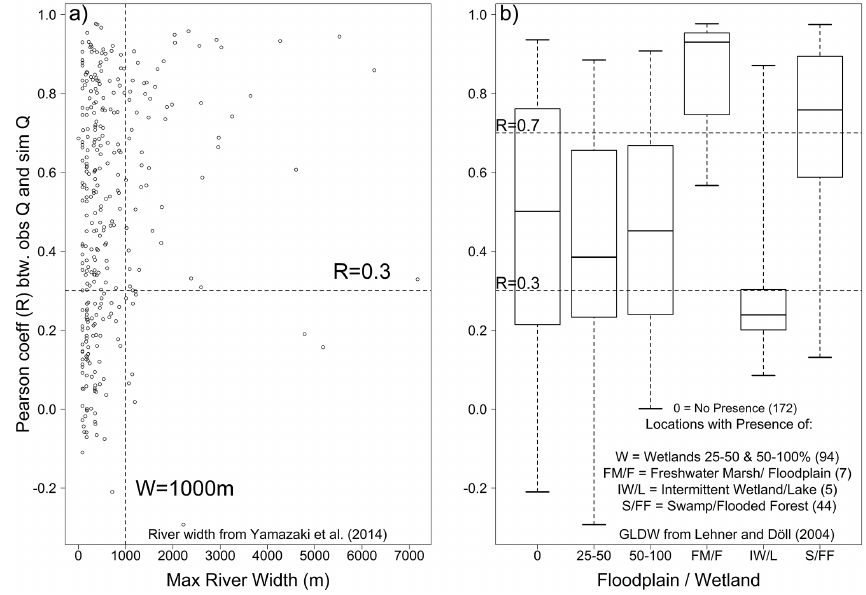
Figure 6. (a) Relationship between R obtained from the validation of satellite-measured discharge and the maximum river width for each location. (b) Relationship between the same R score and the presence of significant floodplains, flooded forest and wetlands. The horizontal dotted line shows the R = 0 . 3 and R = 0 . 7 threshold, and the vertical line is the river width equal to 1km.